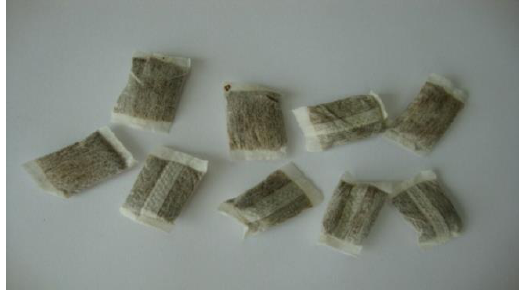
Figure 2. Small fragrant Naswar bags ready for